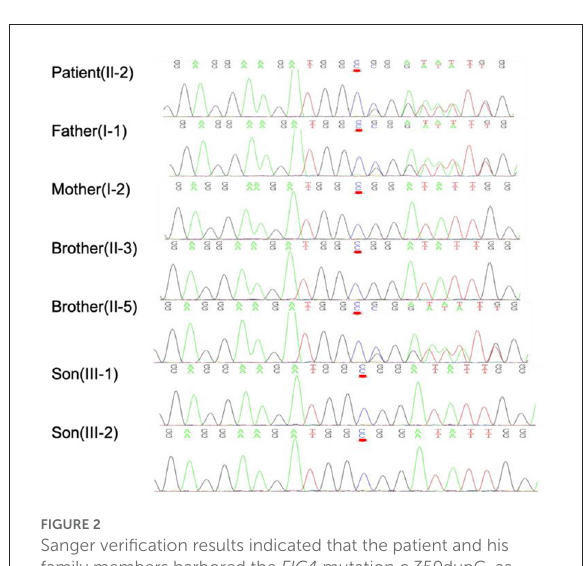
FIGURE2 Sanger verification results indicated that the patient and his family members harbored the FIG4 mutation c.350dupC, as indicated by the red